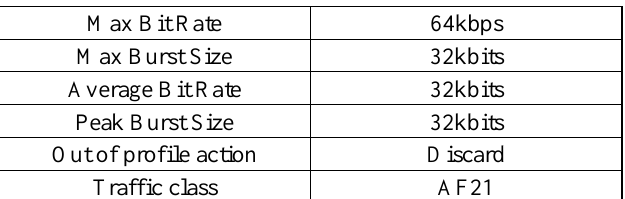
Scenario for Network Topology IPv4 and